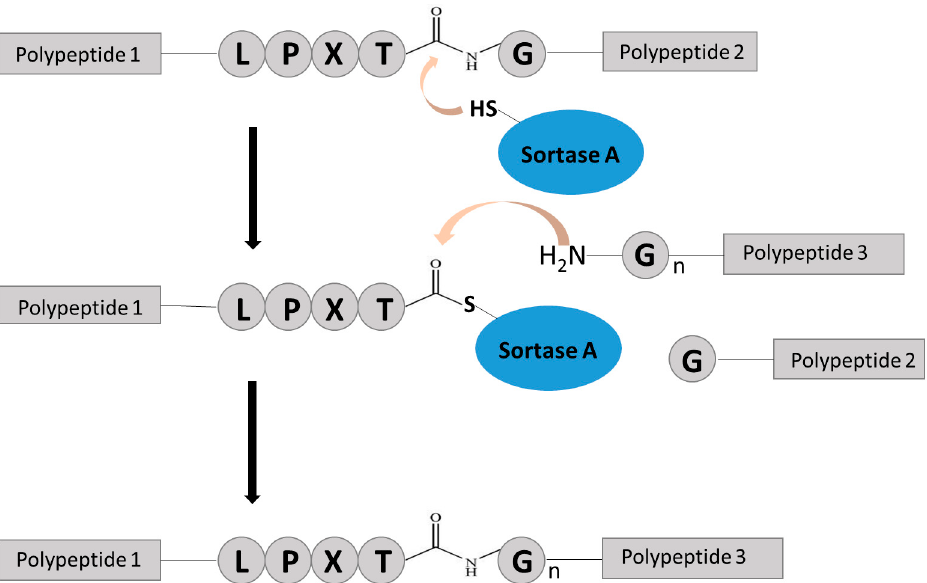
Figure 1. The reaction mechanism of Sortase A. Sortase A could recognize an LPXTG sequence (L, leucine; P, proline; T, threonine; G, glycine; X can be any amino acid), cleave the amide bond between the threonine ( T ) and the glycine ( G ) via an active-site Cys-184 and form a covalent thioester intermediate, then followed by the attack of oligoglycine substrates to produce covalently linked products.